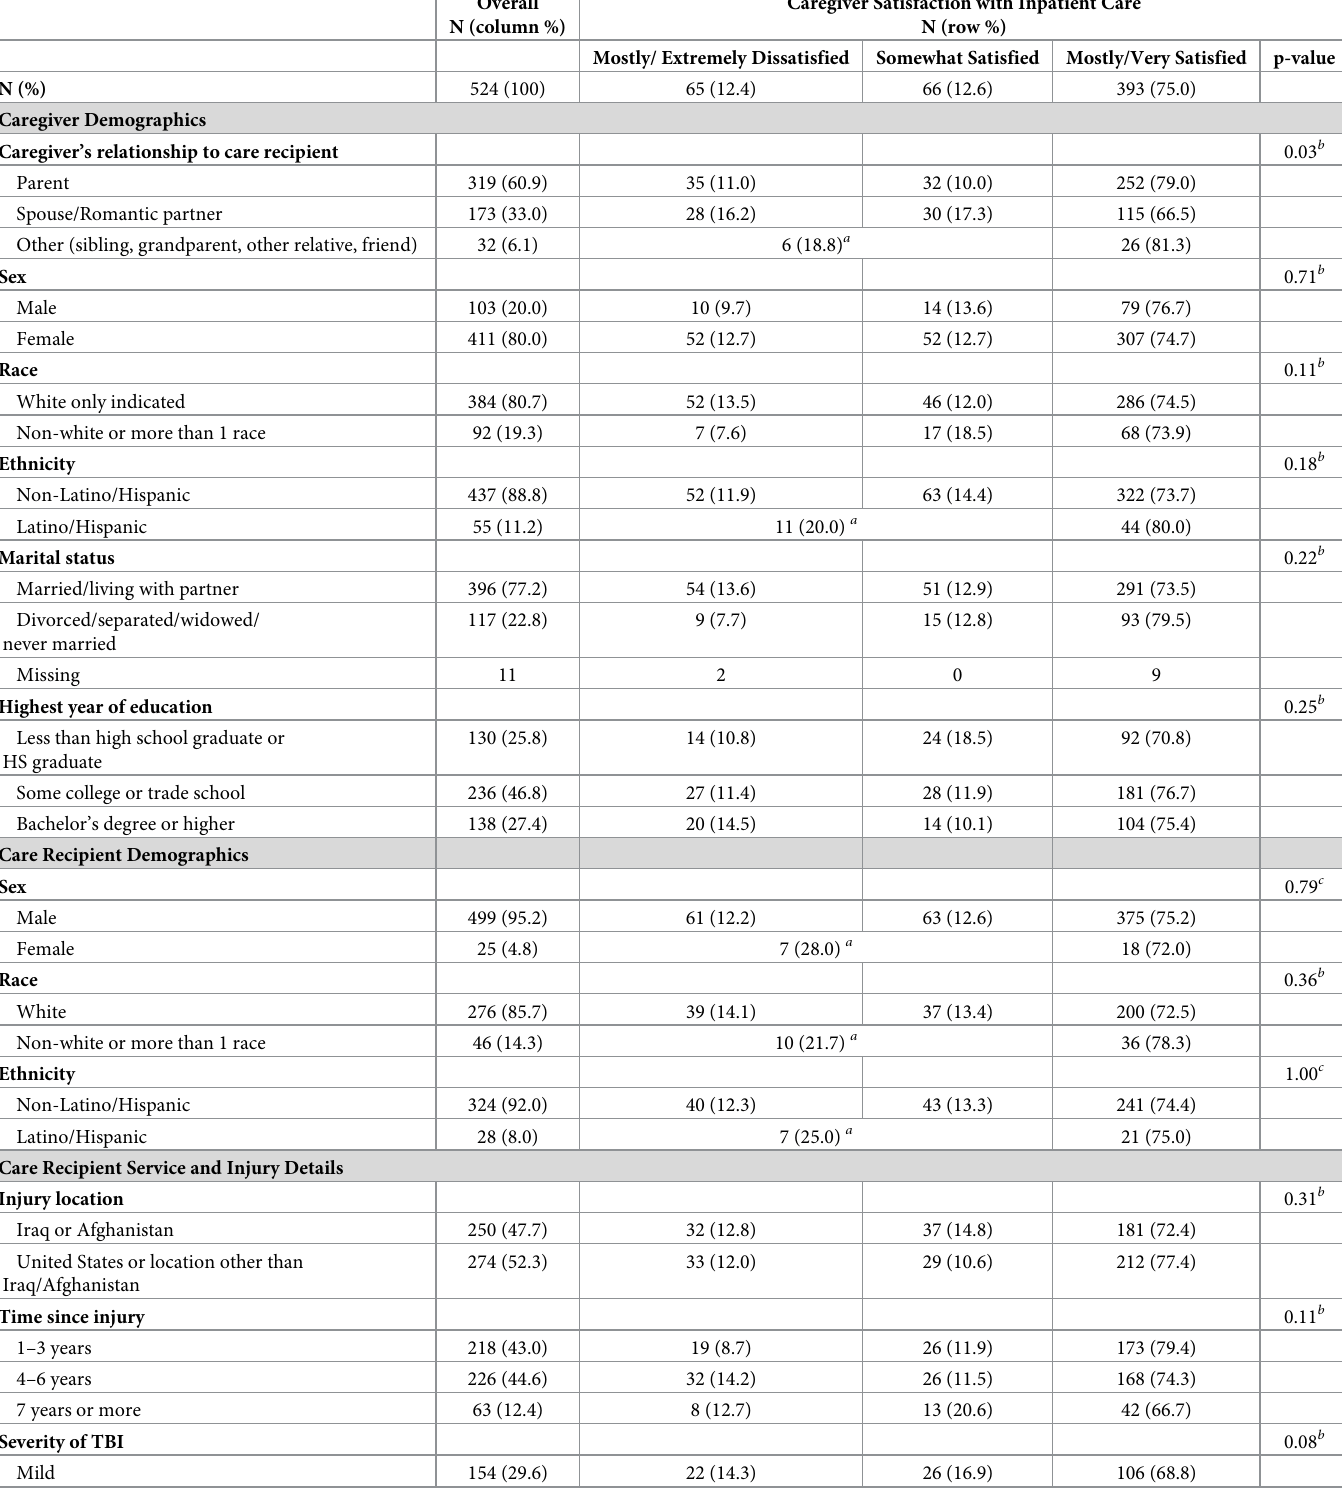
Table 1. Fixed factors versus caregiver satisfaction with inpatient